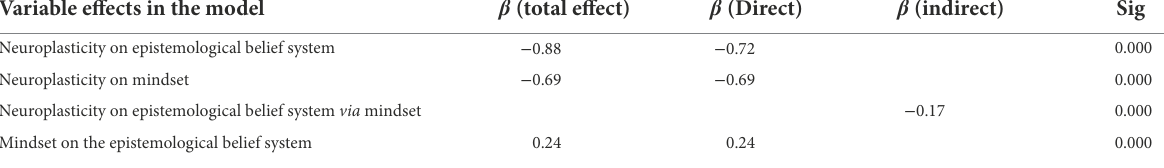
TABLE 4 The path coefficients of the main variables in the model.